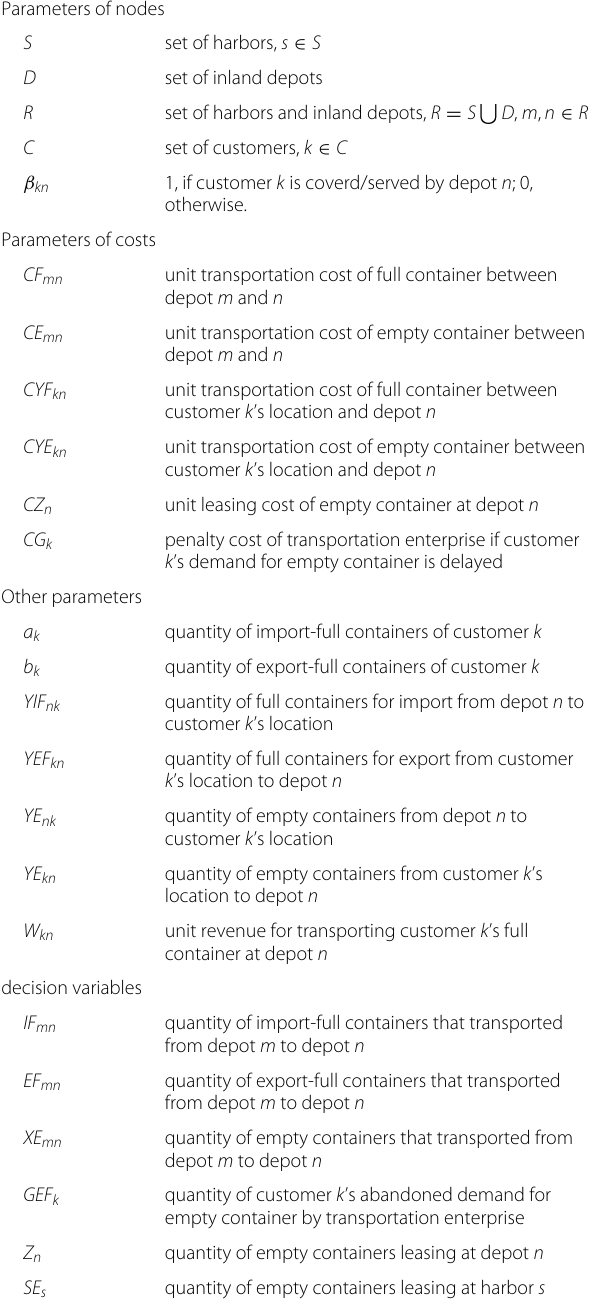
Table 1 Notations for the model Parameters of